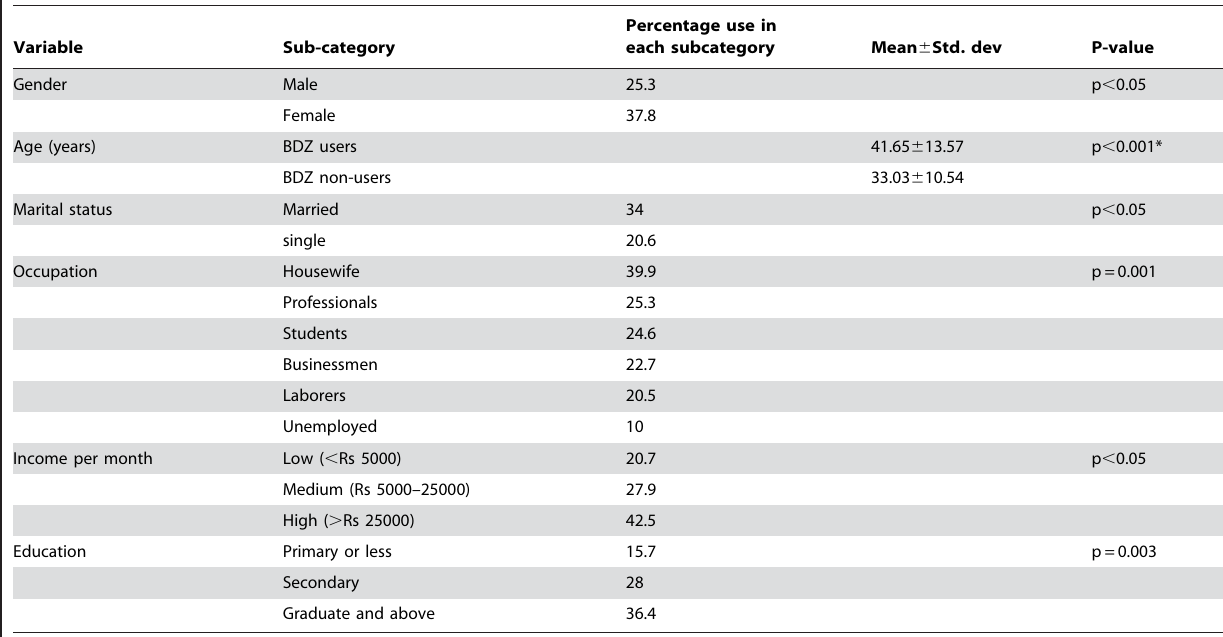
Table 2. Characteristics of persons who reported BDZ use